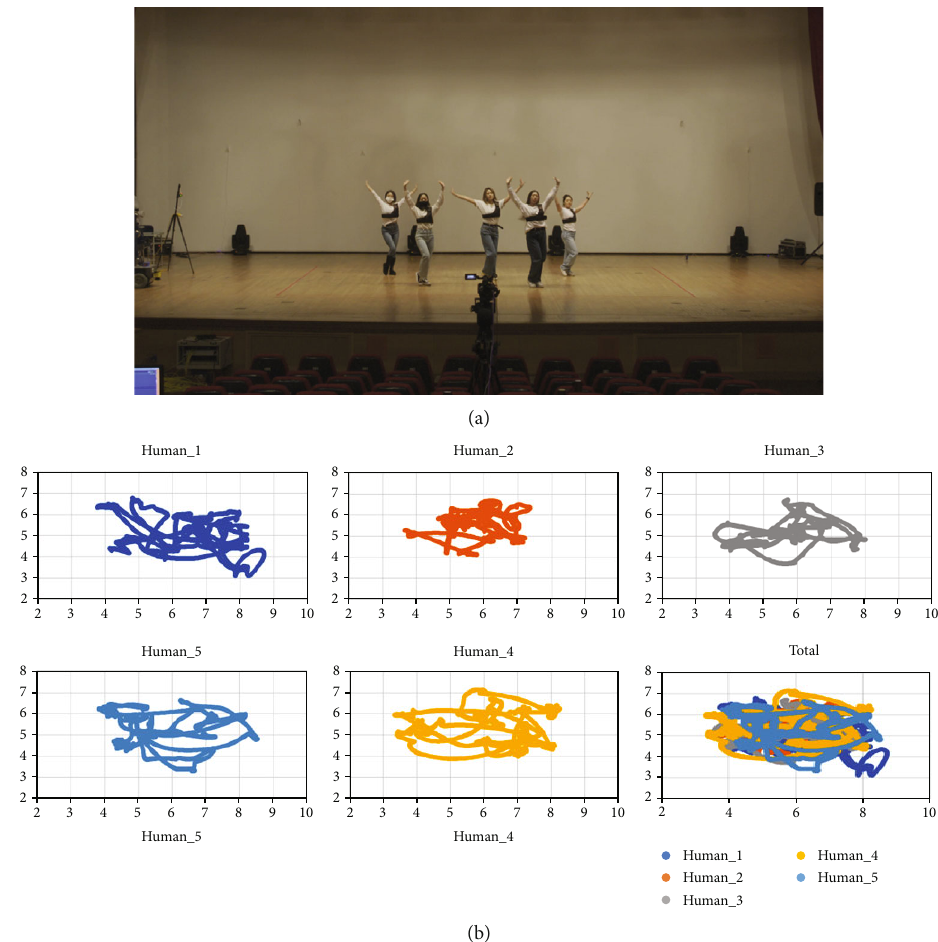
Figure 6: (a) Five dancers whose movement data are obtained during rehearsal. (b) Final obtained movement data of each dancer.